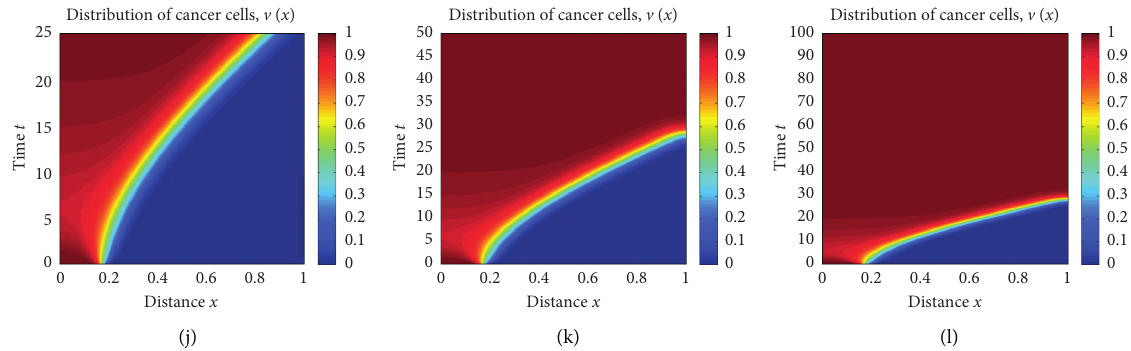
Figure 7: The spatial-temporal evolutions of the cancer cells’ diffusion coefficients for t � 25, t � 50, and t � 100 with antigenicity parameter c � 0 . 000475. The top row is for d � 0 . for d 2